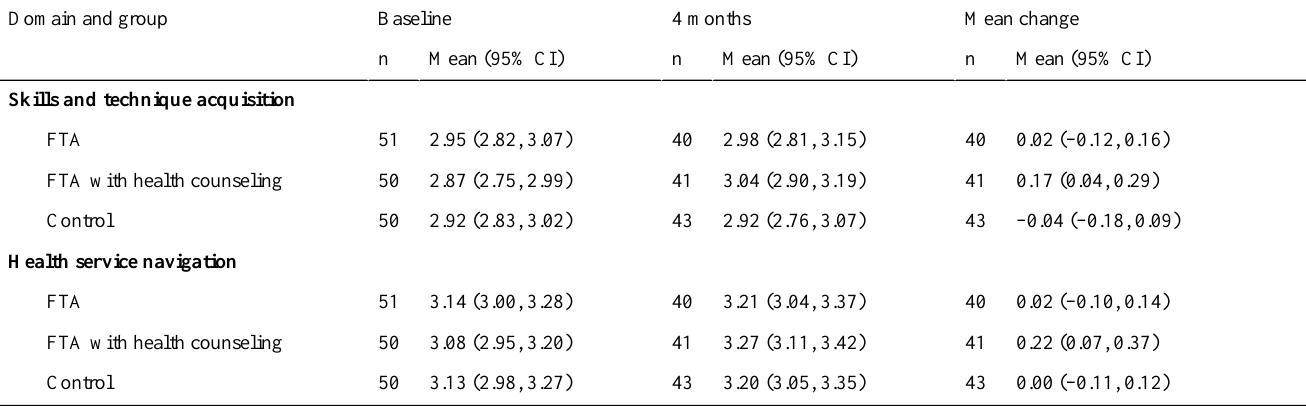
Table 5. Changes in 2 heiQ domains from baseline to 4 months.